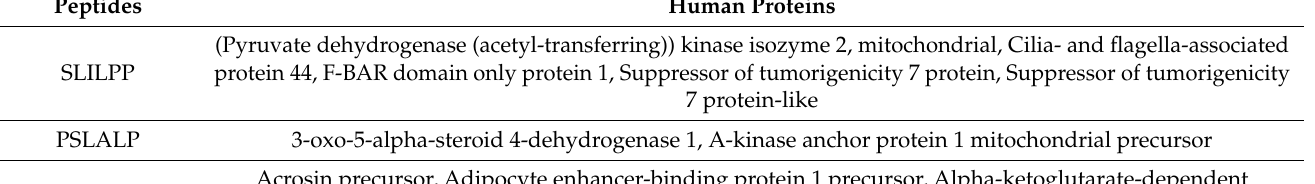
Table 3. Peptide sharing between HTLV-1-derived epitopes and human